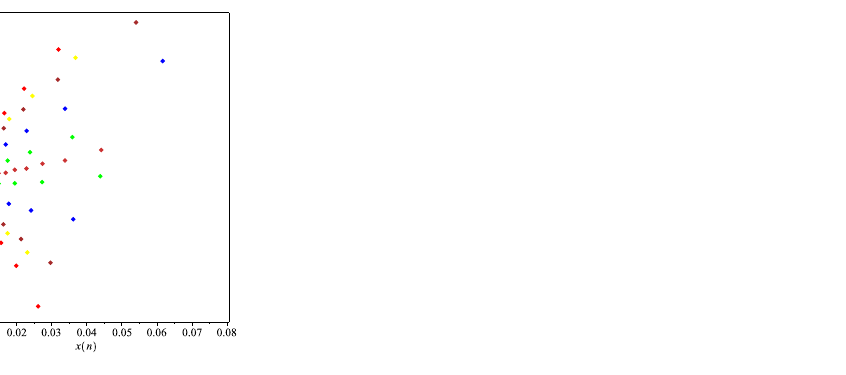
Figure 7. The prey-free equilibrium is also globally attractive at this time. Example 3. The impact of fear effect on system stability is studied by numerical simulations.